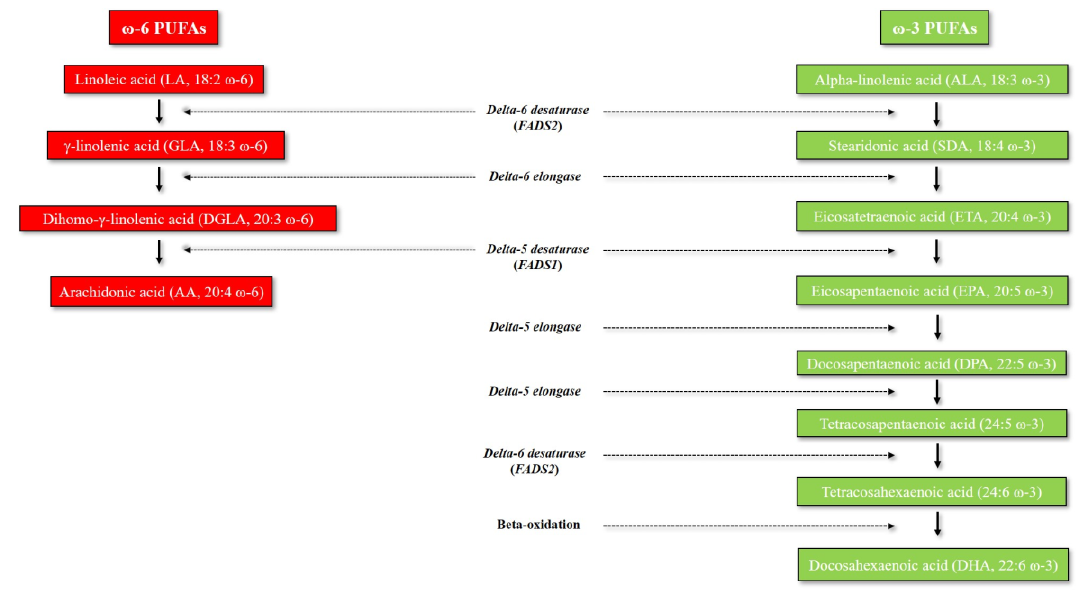
Figure 1. Metabolism of omega-3 and omega-6 PUFAs. Abbreviations: FADS, Fatty acid desaturase; PUFAs, polyunsaturated fatty acids.